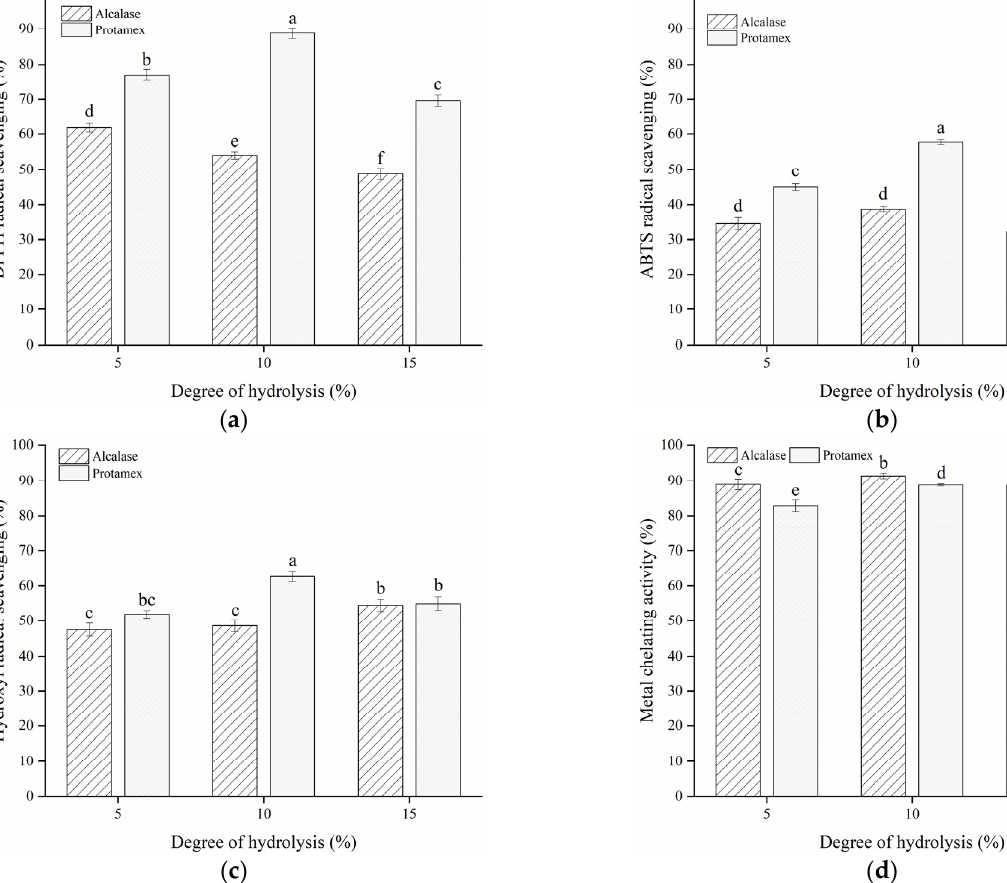
Figure 2. DPPH radical scavenging activity ( a ), ABTS radical scavenging activity ( b ), hydroxyl radical scavenging activity ( c ) and metal chelating activity ( d ) of bone hydrolysates prepared by Alcalase and Protamex. Different letters indicate the results differ significantly ( p < 0.05).